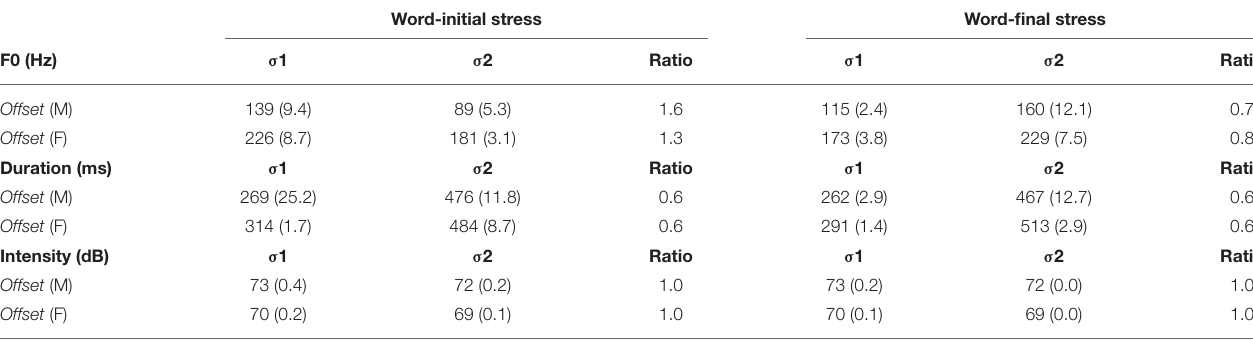
TABLE 2 | Mean F0, duration, and intensity of the English critical stimuli (standard